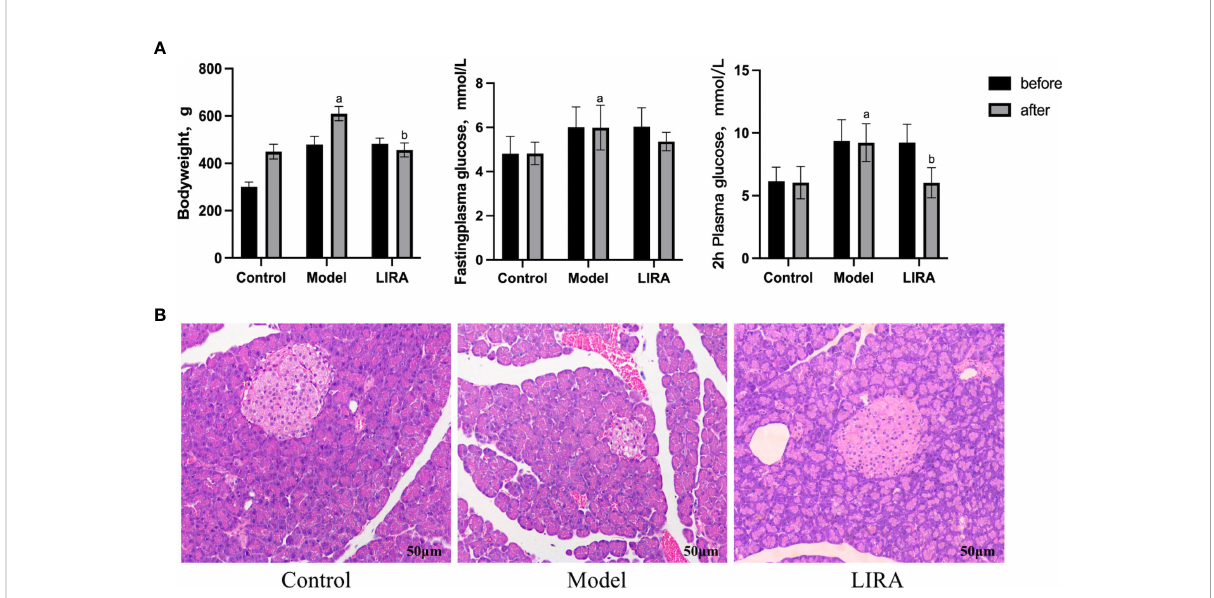
FIGURE 2 (A) Changed of body weight/FPG/2hPG of rats in each group before and after intervention (n=9). Compared with Control group, a P <0.05; Compared with Model group, b P <0.05. (B) The morphology and structure of islets were observed by HE staining (200×). From left to right are control, model and LIRA